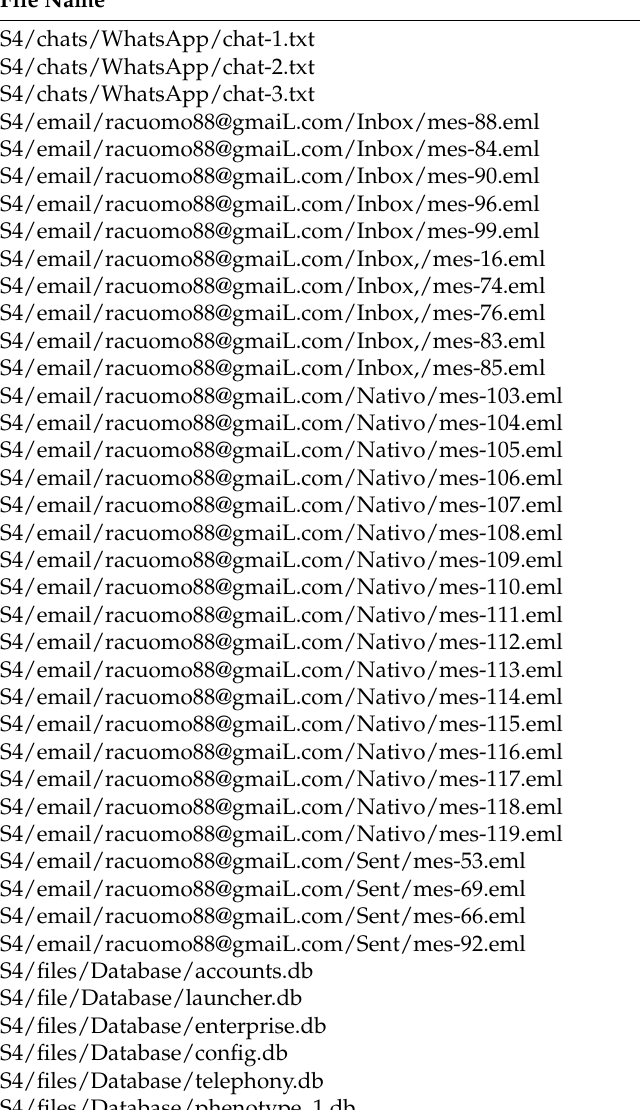
Table 1. List of the file extracted from the smartphone under analysis with the hash code modified. All of them have been created by the